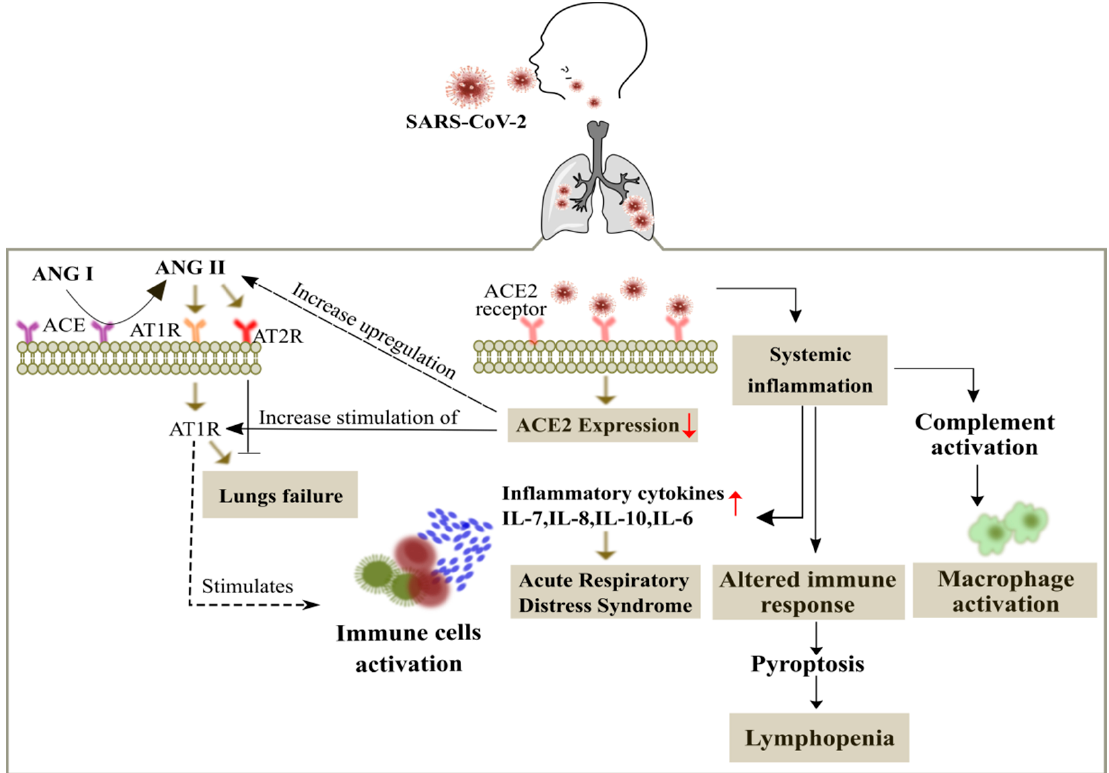
Figure 1. Overview of the SARS-CoV-2 in the cancer patients. The entry of SARS-CoV-2 is mediated by binding of the spike protein to the angiotensin-converting enzyme II (ACE2) receptor (abundantly expressed on alveolar epithelial cells) with a subsequent membrane fusion leading to the down regulation of the ACE2 receptor. This in turn leads to the activation of angiotensin type 1 receptor (AT1R) through up regulation of angiotensin (ANG II). ANG II is also produced from ANG I through the renin-angiotensin system regulated by the angiotensin-converting enzyme (ACE). Up regulation of ANG II leads to respiratory failure and ANG II interferes with the adaptive immunity by activation of immune cells and increases the production of inflammatory cytokines to promote acute respiratory distress syndrome (ARDS). Viral infected patients also show widespread complement activation that leads to accumulation of macrophages, along with lymphopenia as an indicator of the seriousness and hospitalization in the infected patients.